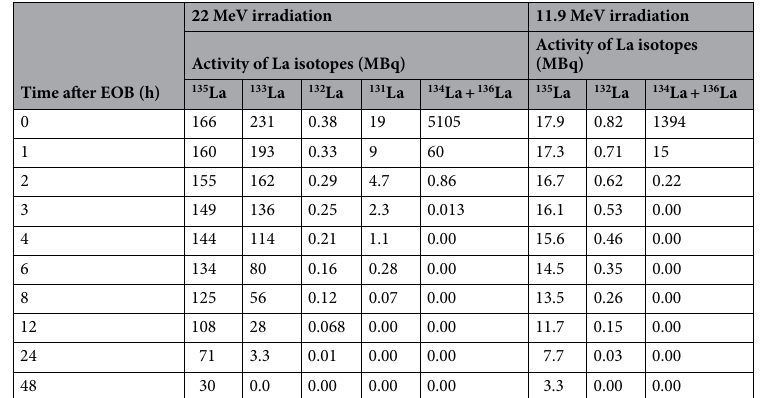
Table 1. Average activities of La isotopes of interest at time-points after EOB for 500 µA·min runs (n = 3) at 22 MeV and 11.9 MeV proton beam energies.